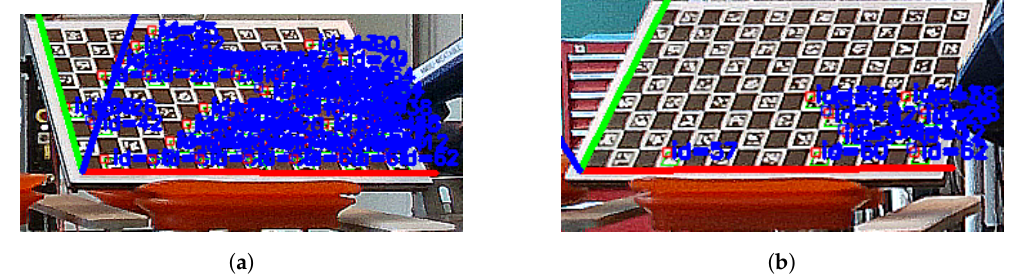
Figure 14. Charuco double-sided board marker detection for pose estimation. ( a ) Camera 1. ( b ) Camera 2.